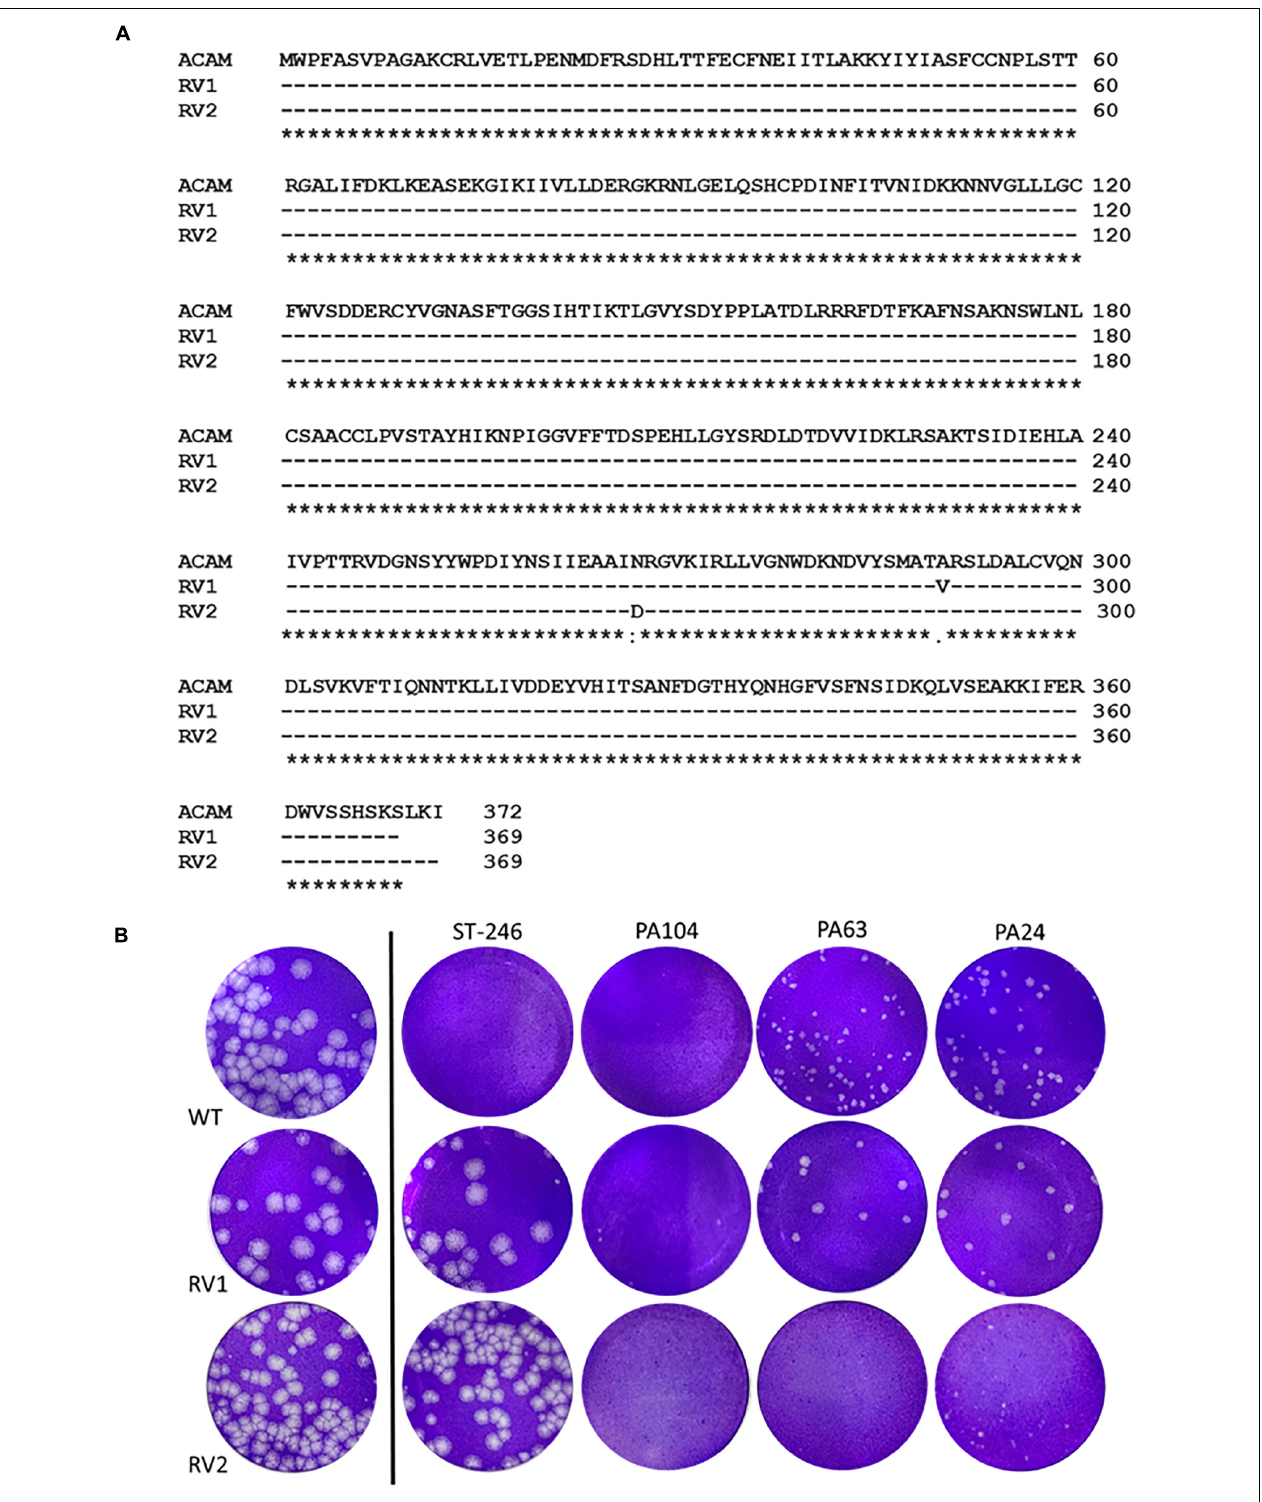
FIGURE 5 | Retro-1 analogs PA104, PA24, and PA63 inhibit viral spread of ST-246-resistant VACV. (A) RV1 and RV2 sequence alignments showing preserved A290V and N267D mutations, respectively. Amino acid alignment of F13 of lab-grown RV1 viral isolates and RV2 compared to published ACAM strain (Lederman et al., 2012). (B) Plaque assay images showing observable decrease in viral plaque size of RV1 and RV2 virus in the presence of 10 µ M PA104, PA24, and PA63.